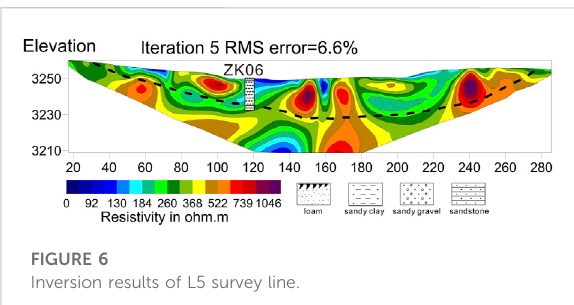
FIGURE 6 Inversion results of L5 survey